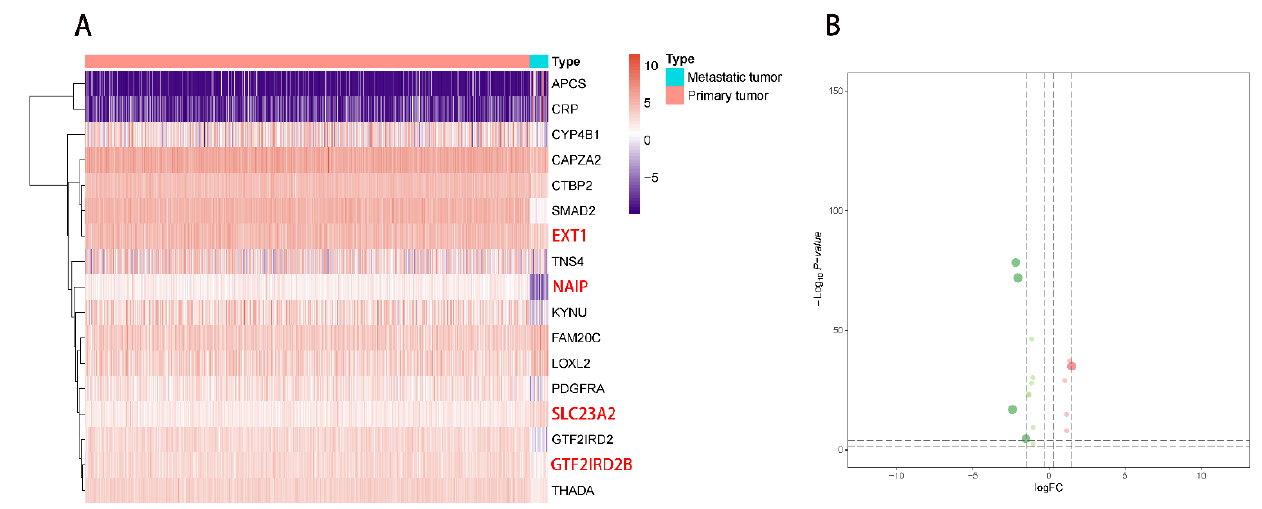
Figure 6. Differential expression analysis of target genes of eRNAs. ( A , B ) Differential expression analysis of target genes of eRNAs. Seventeen differentially expressed target genes of eRNAs were defined between primary NSCLC and metastatic NSCLC. In the heatmap plot ( A ), red color repre- sented primary NSCLC and blue color represented metastatic NSCLC. In the volcano plot ( B ), red dot represented the upregulated part and green dot represented the downregulated part in target genes of eRNAs, the two dashed horizontal lines mark the positions of p -value = 0.05 and p -value = 0.0001, respectively, and the four vertical dotted lines mark the positions of log2 foldchange (logFC) = −1 .5, logFC = −0 .3, logFC = 0.3 and logFC = 1.5, respectively. eRNAs, enhancer RNAs; NSCLC, non- small cell lung cancer.